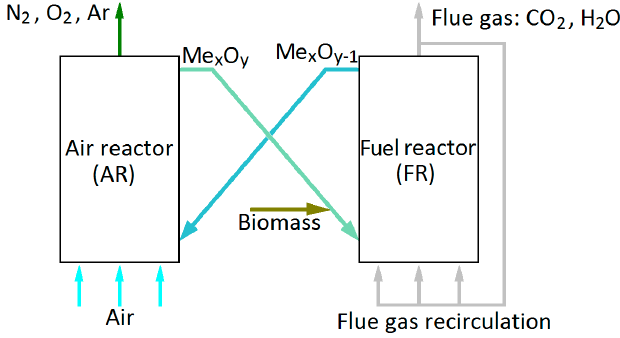
Figure 2. Schematic drawing of the CLOU reactor system.